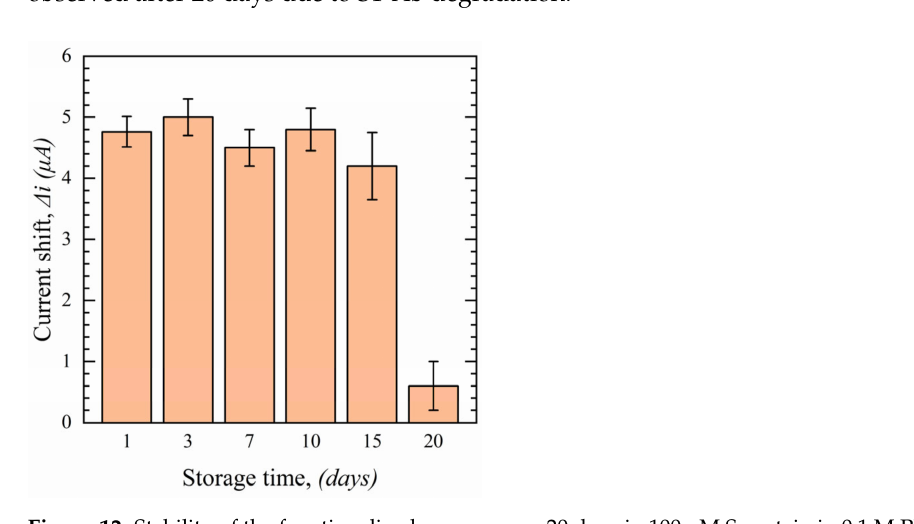
Figure 12. Stability of the functionalized sensors over 20 days in 100 nM S protein in 0.1 M PBS ( n =